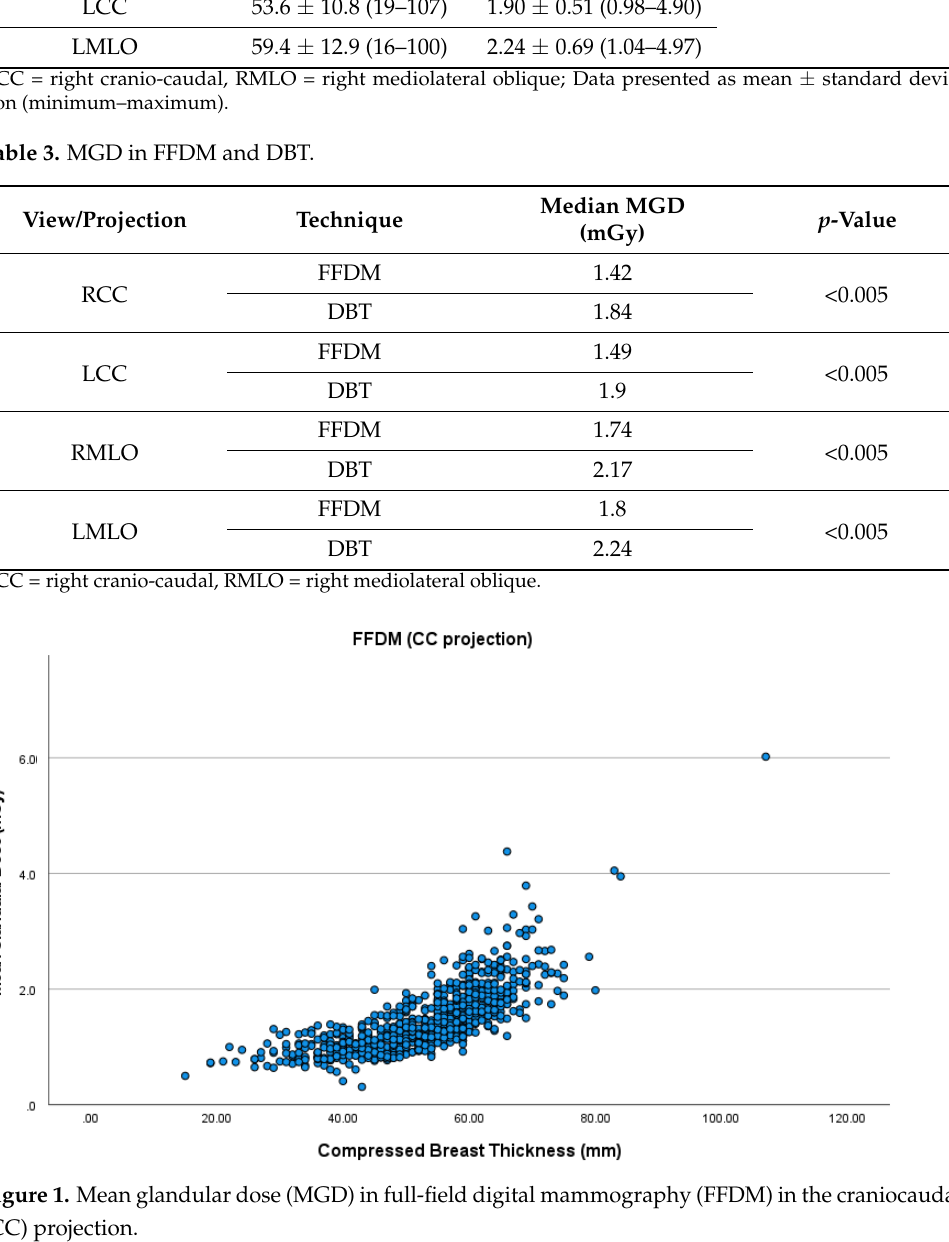
Table 3. MGD in FFDM and DBT.